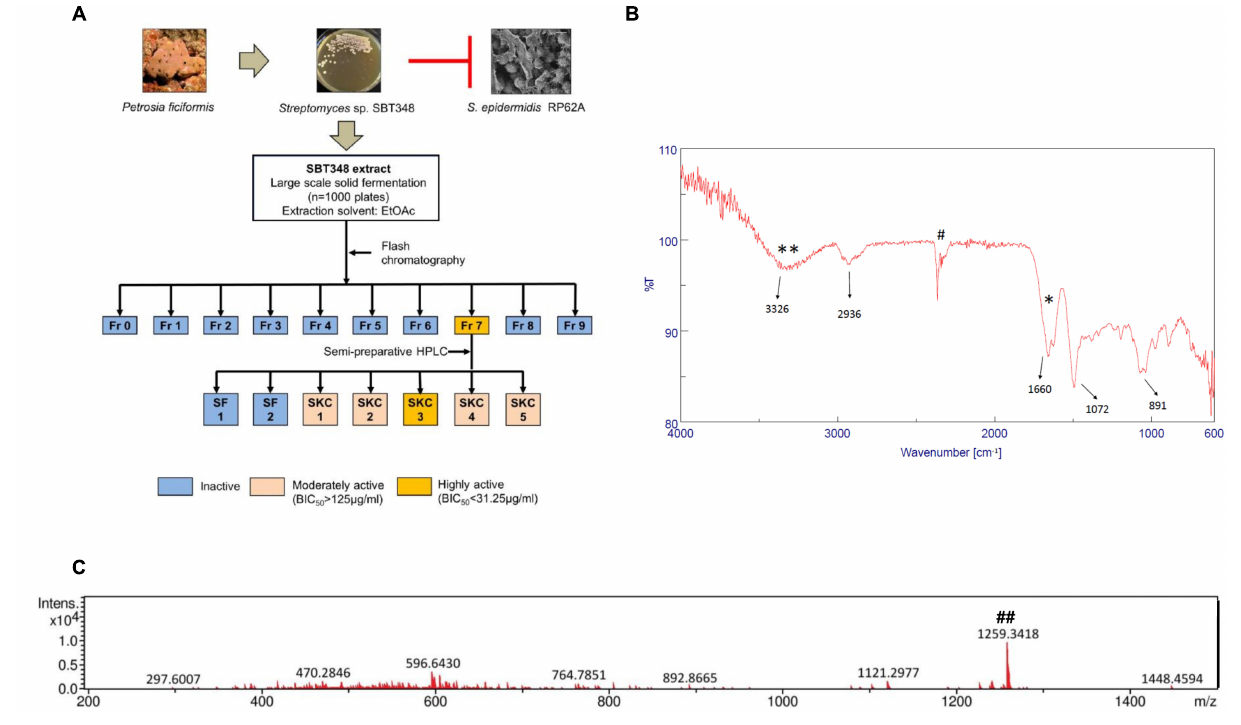
FIGURE 2 | (A) Bioassay-guided fractionation scheme employed for isolation of active compound SKC3 in the SBT348 extract. Crystal violet biofilm assay (on 96-well plate against Staphylococcus epidermidis RP62A) was done in each step for identification of active anti-biofilm fraction (Fr), sub-fraction(s) (SF), and pure compound (SKC3). (B) Electrospray ionization-mass spectrometry spectra of SKC3. ## Mass of SKC3 molecular ion [M+H] + of 1259.3418 Da could be seen. Neutral mass of SKC3, 1258.3346 Da (C) Fourier transform-infrared spectroscopy of SKC3 representing the presence of strong absorption troughs at 1660 ( ∗ ), 1072,